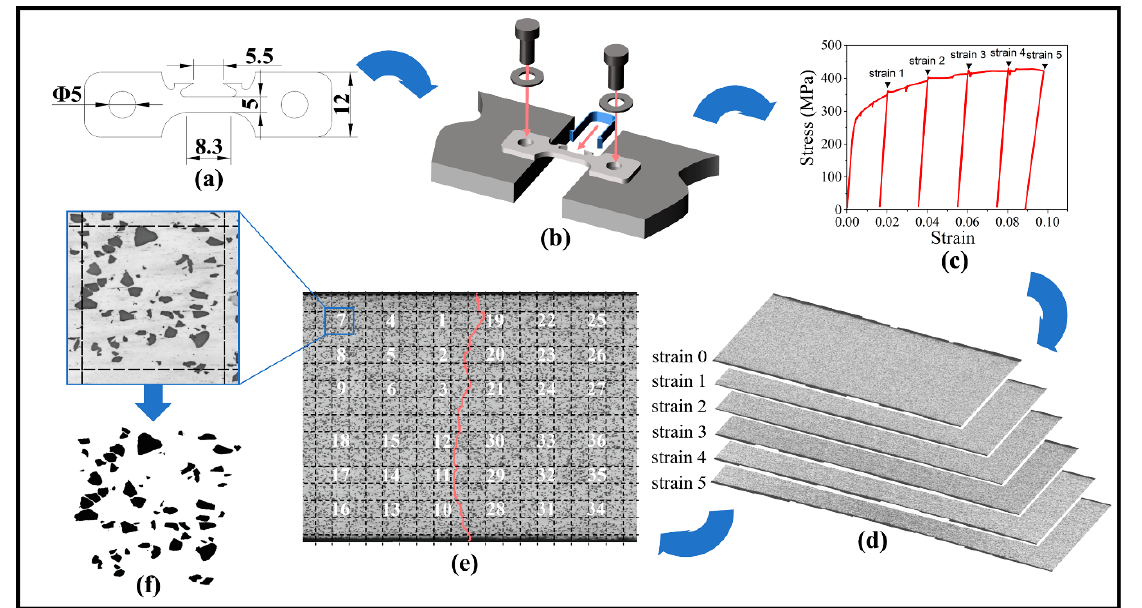
Figure 1. Schematic of the in situ observation process: ( a ) the dimension (mm) of the specimen, ( b ) the equipment setting, ( c ) the stress–strain curve of the intermittent loading testing, ( d ) the dimension of the image stacking, ( e ) the image sampling method, and ( f ) image of one sampling square and its binary image.